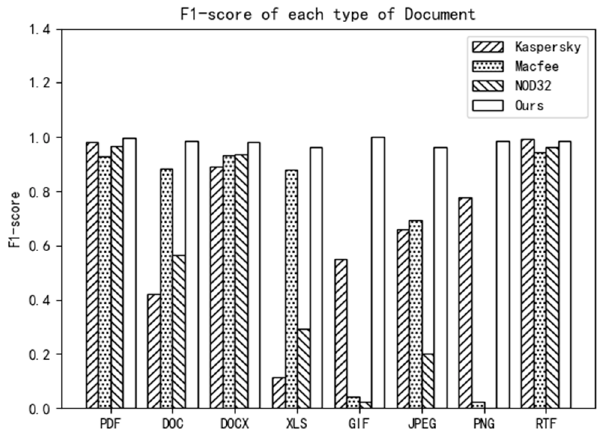
Figure 4. The F1-scores of various types of documents.